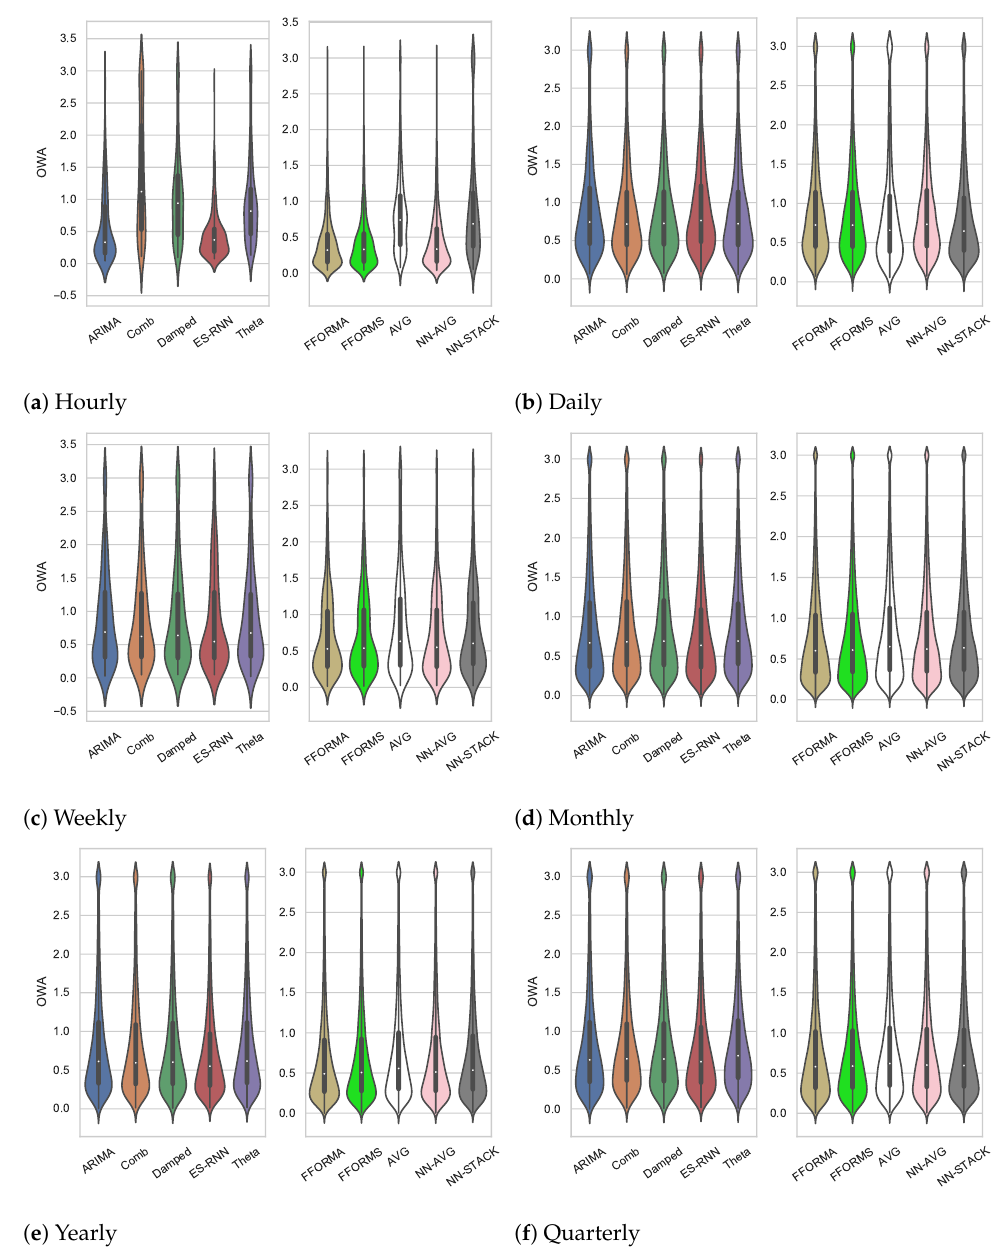
Figure 3. The OWA error distributions on the M4 test set, where FFORMS represents the similar distributions of FFORMS-R and FFORMS-G. Where ( a ) shows the distributions for the Hourly subset, ( b ) the Daily subset, ( c ) the Weekly subset, ( d ) the Monthly subset ( e ) the Yearly subset and ( f ) the Quarterly